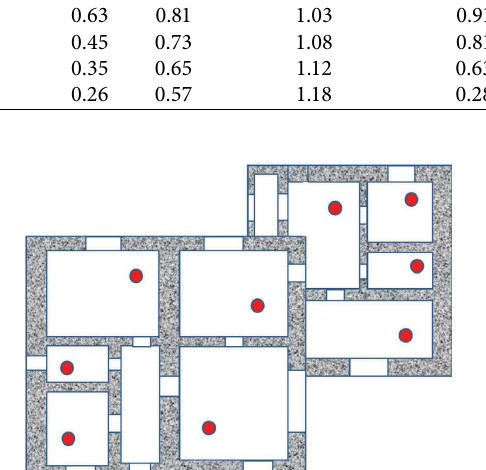
Figure 12: Plan of the premises with the location of MSH.